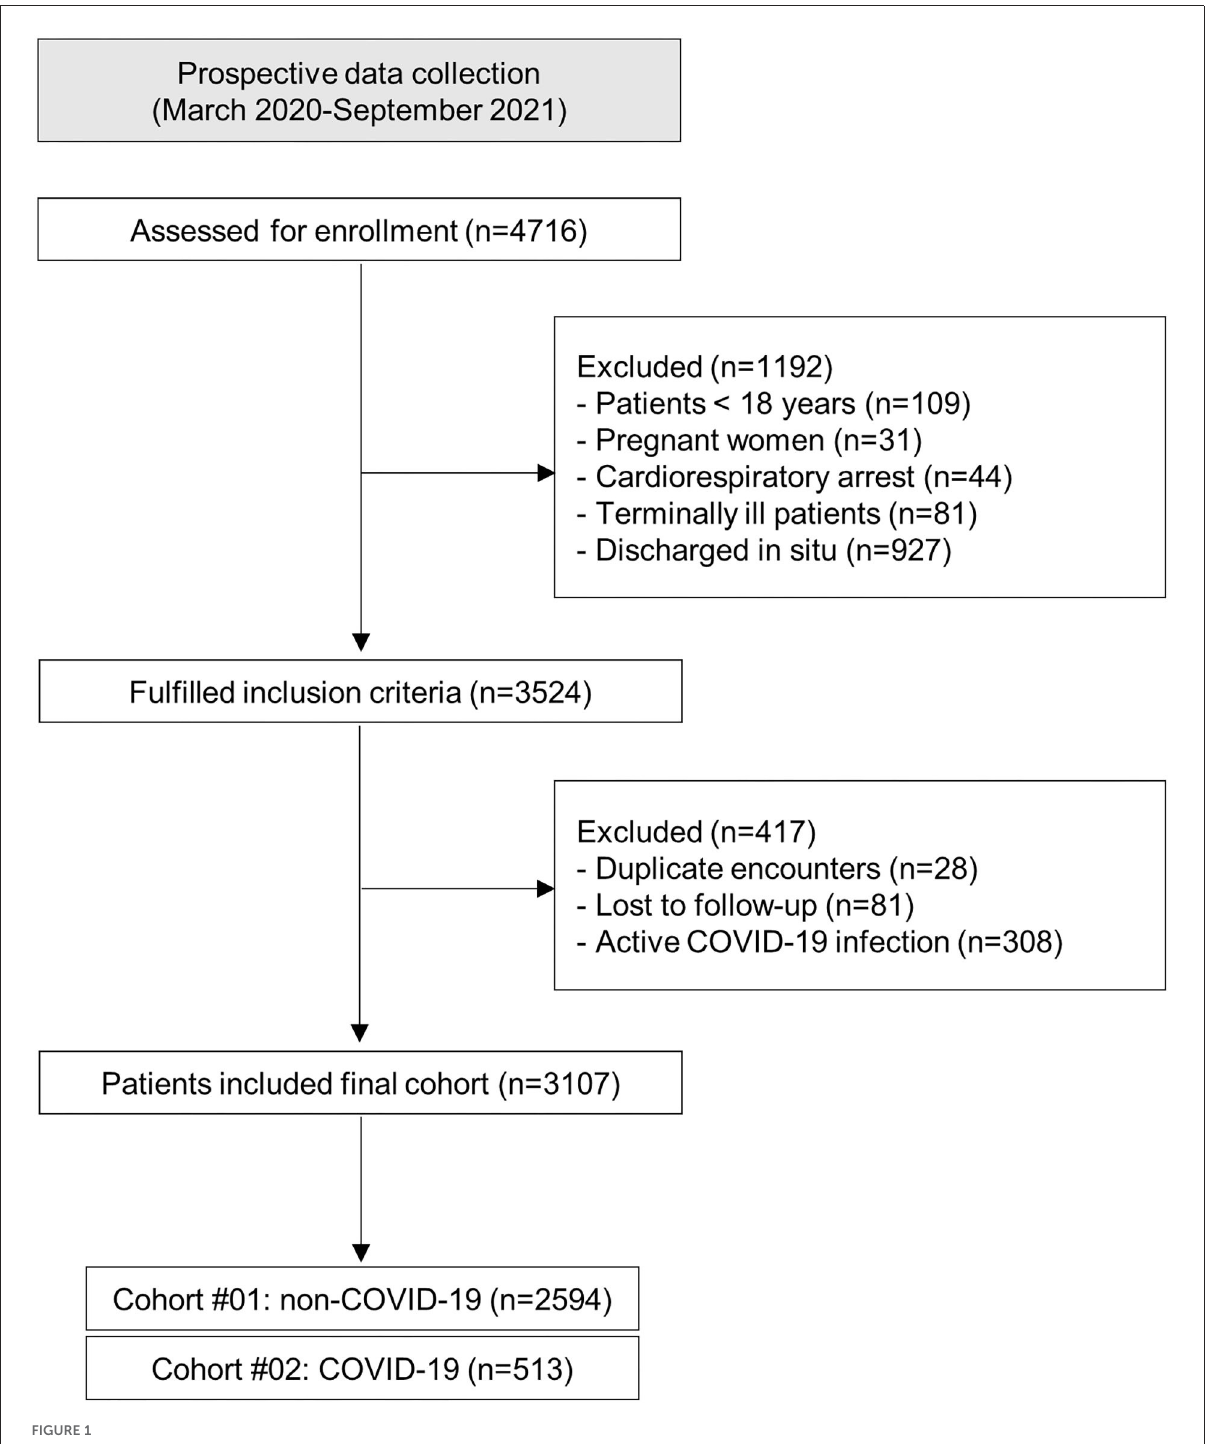
FIGURE1 Study flowchart. COVID-19, coronavirus disease 2019.